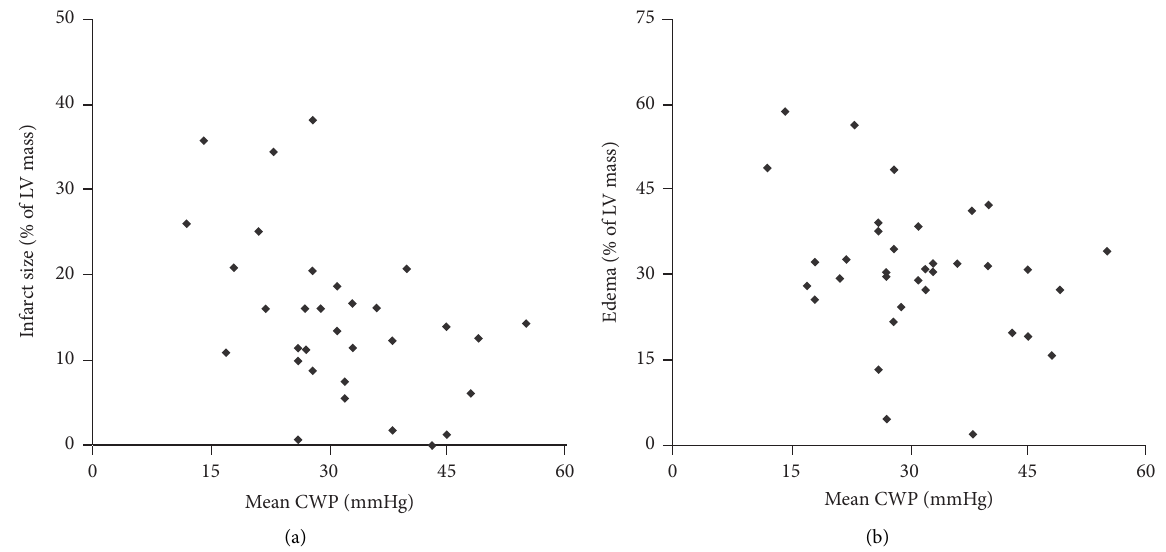
Figure 1: The association between mean CWP, infarct size, and intramyocardial edema. (a) An inverse, statistically significant association was identified between mean CWP and infarct size, expressed as percentage of left ventricular mass ( p � 0 . 01 ) . (b) An inverse, statistically significant association was identified between mean CWP and intramyocardial edema, expressed as percentage of left ventricular mass ( p � 0 . 05 ) . CWP � coronary wedge pressure and LV � left